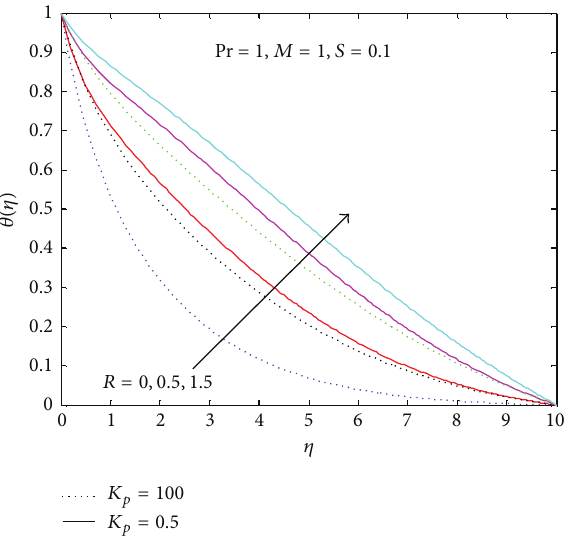
Figure 5: Temperature distribution for 𝑅 and 𝐾 𝑝 .